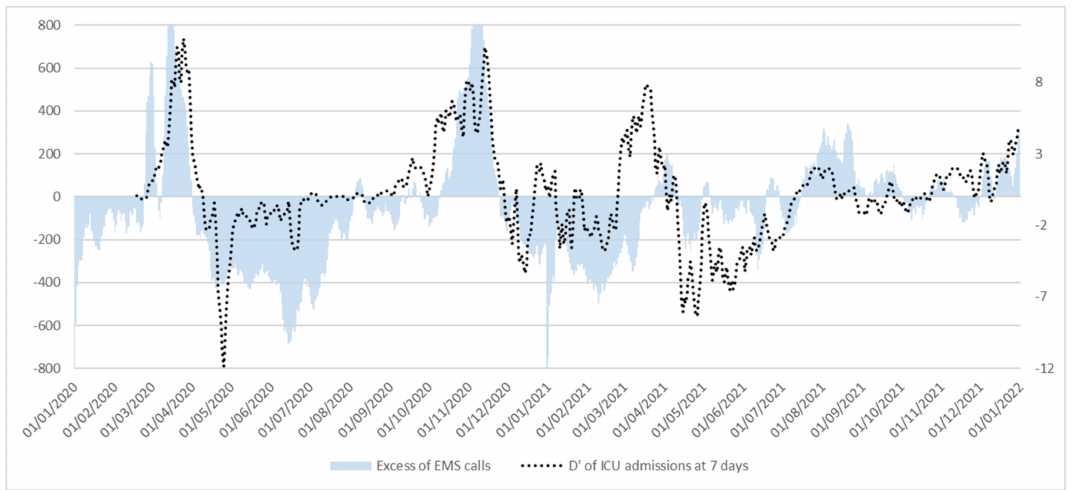
Figure 5. Excess of EMS calls (top) and 1st-order derivative of ICU admission at 7 days (bottom) in Lazio region, Italy,